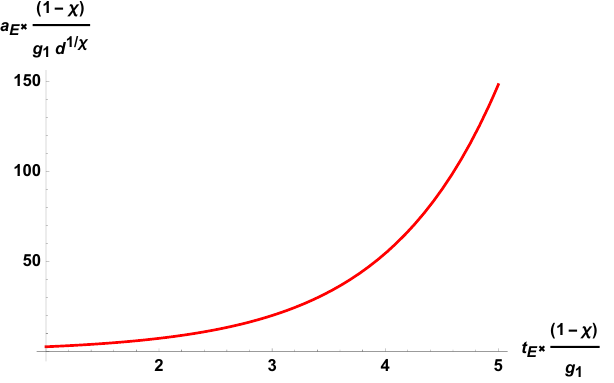
Figure 11 . The scale factor a E ( t E ) (multiplied by some convenient constant) in Einstein frame in the model with χ = 0 . 1 , n S = 1 , and µ = 1